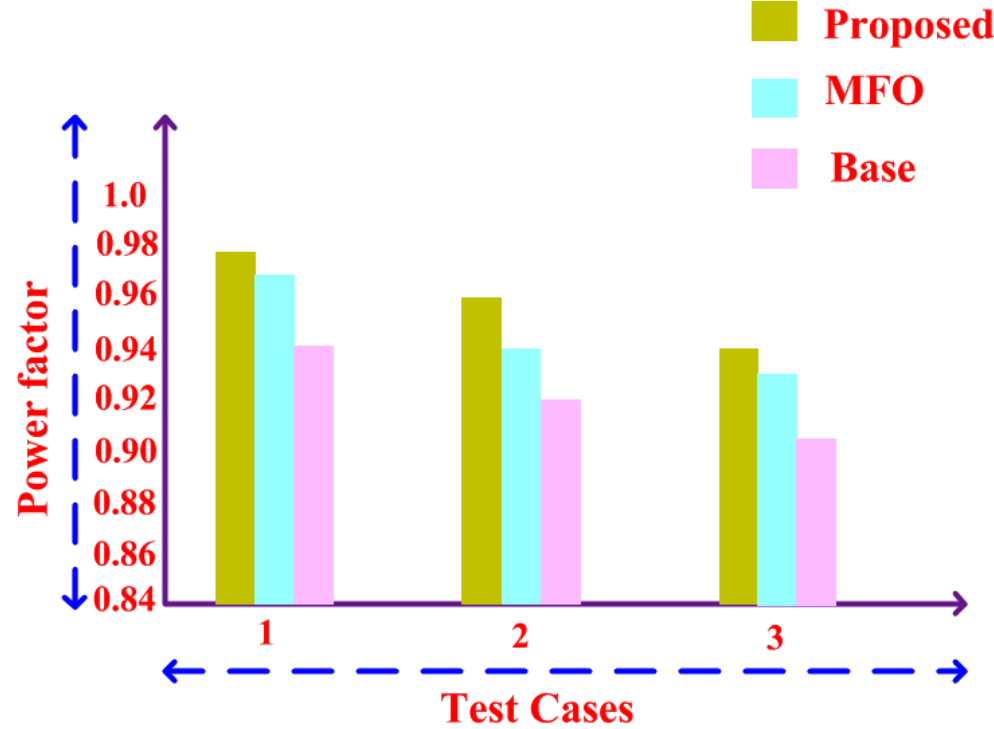
Figure 14. Performance comparison of power factor with different test cases.